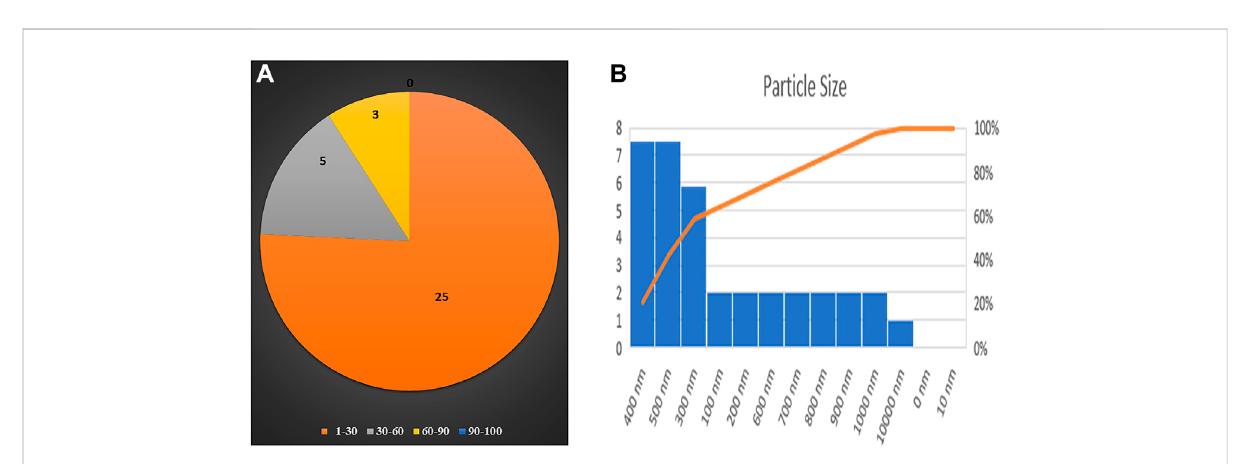
FIGURE 7 Particle size distribution of M - CuO NPs on the basis of (A) TEM and (B)